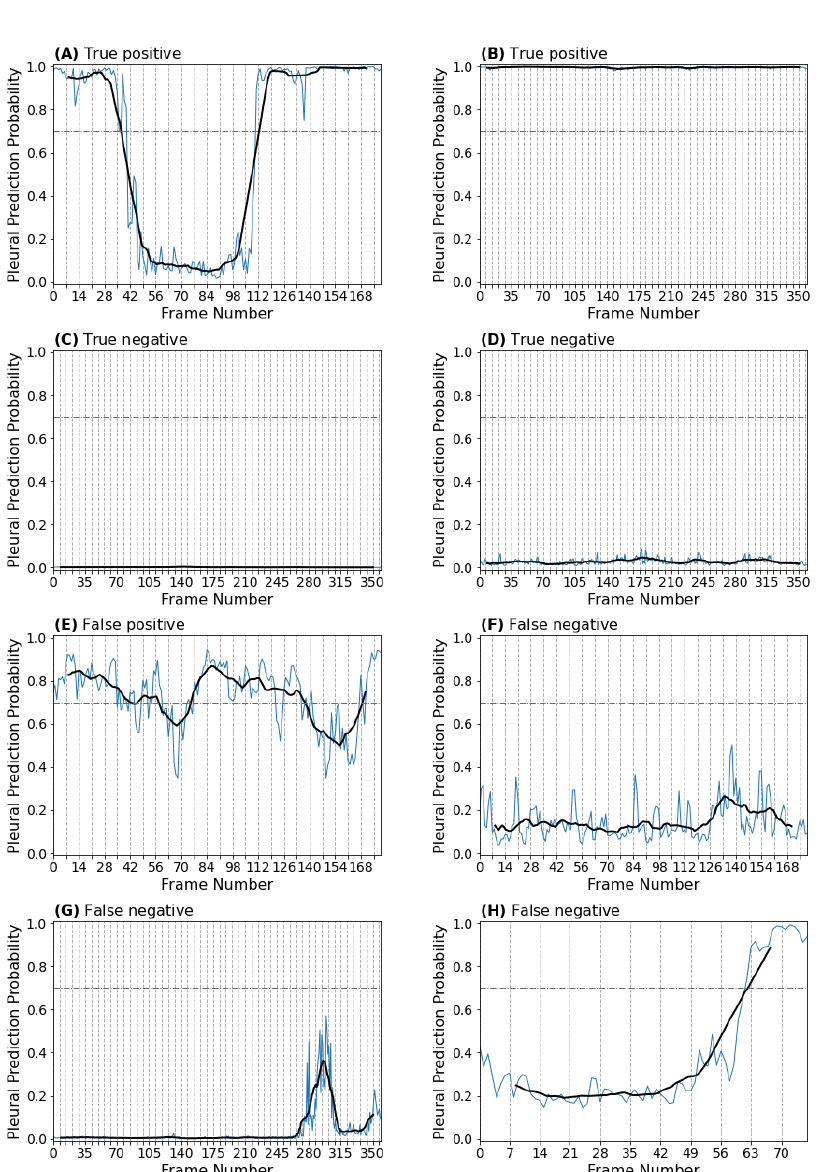
Figure A2. Additional Pleural predication probability time series for selected true positive ( A , B ), true negative ( C , D ), false positive ( E ), and false negative ( F – H ) clips. Only one additional false positive example is displayed due to the relatively low number of false positives encountered. ( A ) True positive example displaying the curtain sign, with corresponding predictions oscillating between parenchymal and pleural as expected. ( B ) True positive example with strong pleural predictions throughout, corresponding to a clip that demonstrated the diaphragm and liver on screen right, with pleural effusion and consolidated lung on screen left. ( C , D ) True negative examples corresponding to an A-line pattern clip with absent lung sliding ( C ) and a B-line pattern clip ( D ). ( E ) False positive example, corresponding to a clip that was under-gained and relatively deep for a parenchymal acquisition, which hindered visibility of normal parenchymal artefacts and landmarks. ( F , G ) False negative examples corresponding to clips where: ( F ) abdominal organs were visible, but the diaphragm was obscured by a rib shadow; ( G ) the first part of the clip was parenchymal, then the operator moved the probe inferiorly to the level of a pleural view (though the predictions still did not meet threshold for pleural classification); ( H ) abdominal contents were obscured by aerated lung, but come into view at the end of the clip, corresponding to an increase in pleural prediction probability that met the classification, but not the contiguity threshold. Supplementary Videos